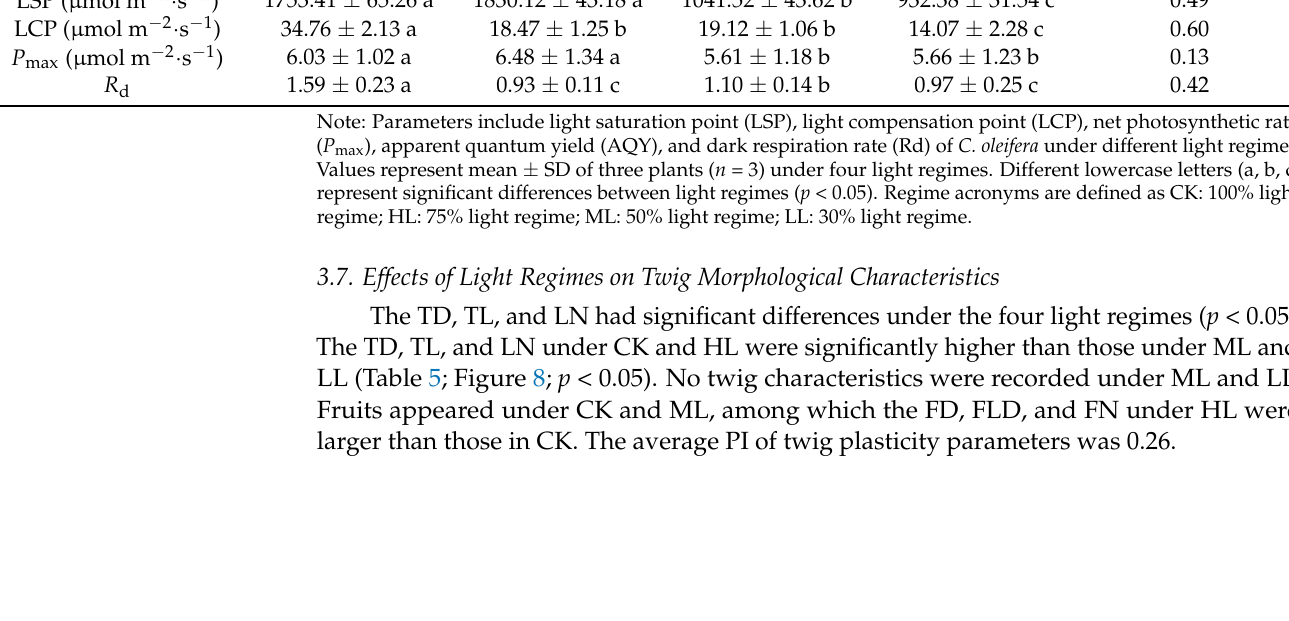
Table 5. Morphology and biomass of C. oleifera twigs under different light regimes.